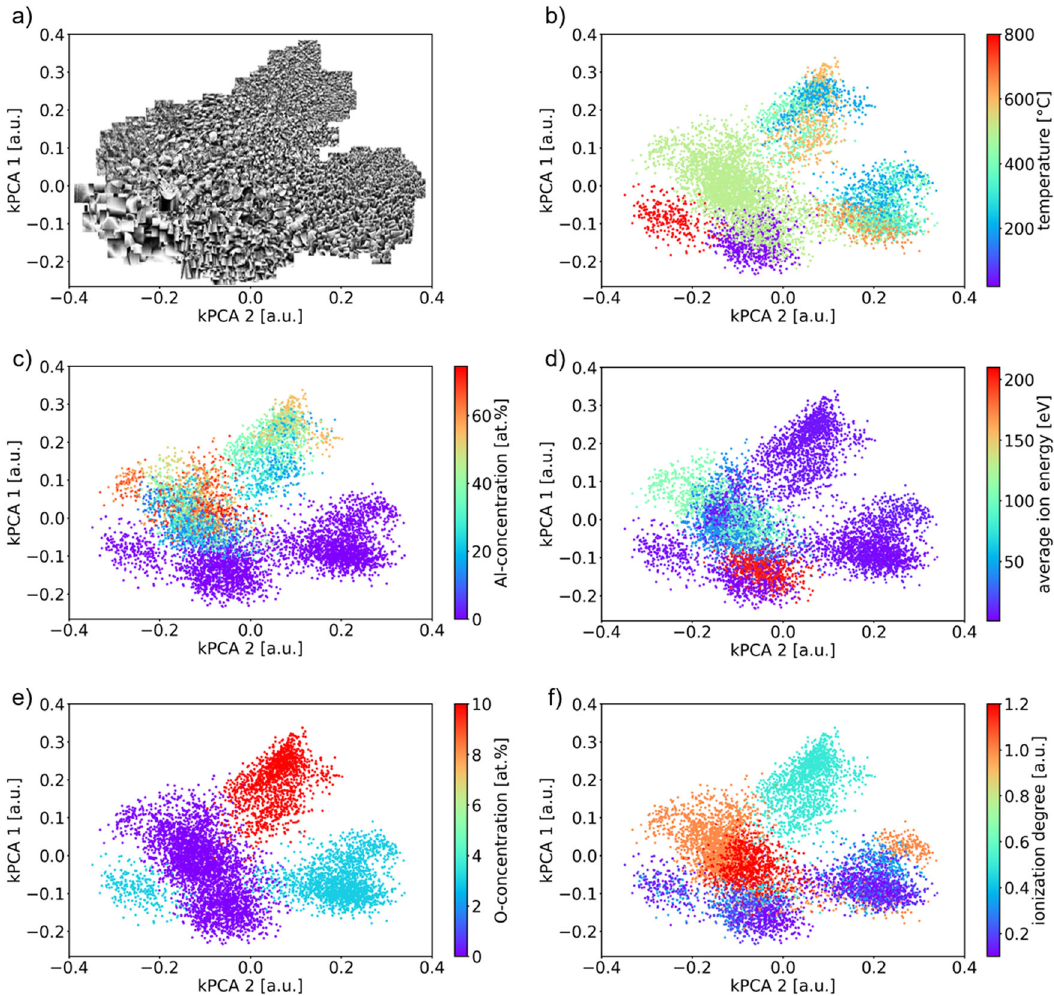
Fig. 2 Visualization of process – composition – microstructure relations. Correlation of the microstructures in the dataset with chemical composition and conditional parameters. VAE latent representation of microstructures ( a ) and conditional parameters b T d , c Al, d E I , e O, and f I d from the validation